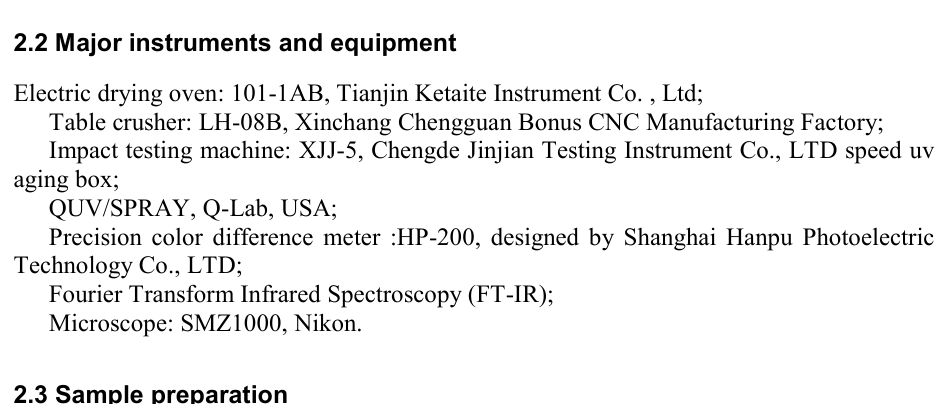
Table crusher: LH-08B, Xinchang Chengguan Bonus CNC Manufacturing